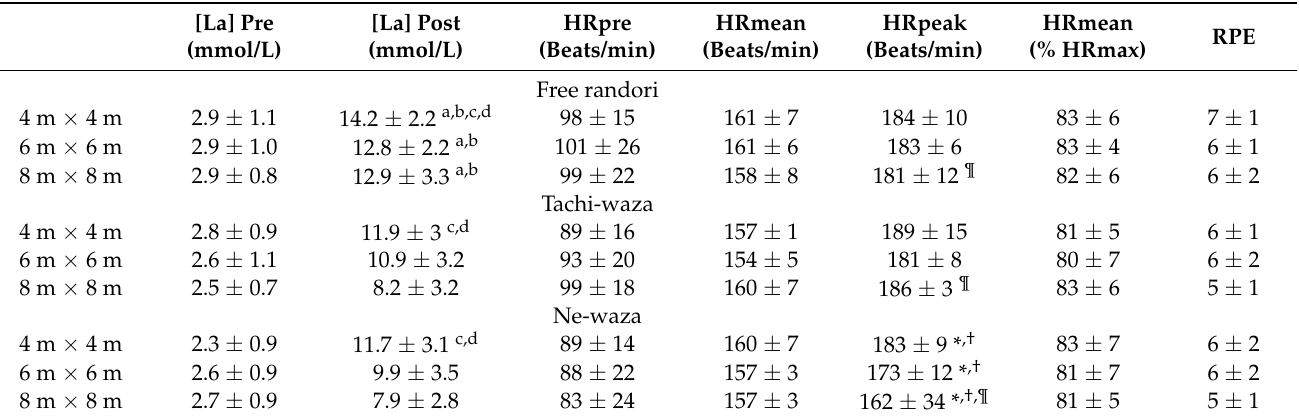
Table 1. Lactate, heart rate, and rating of perceived exertion for different judo female combat conditions (values shown as mean ± standard deviation; n =